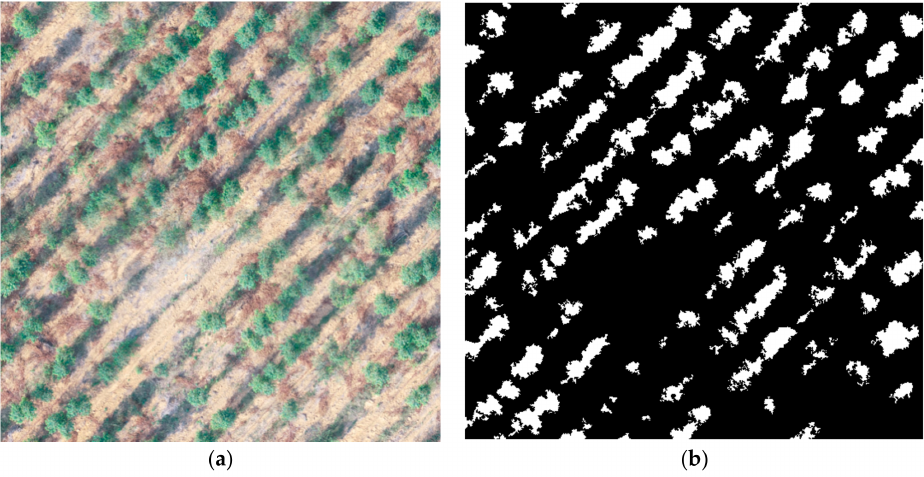
Figure 7. RGB image and canopy image of Test_1: ( a ) RGB image; ( b ) binary image of canopy.